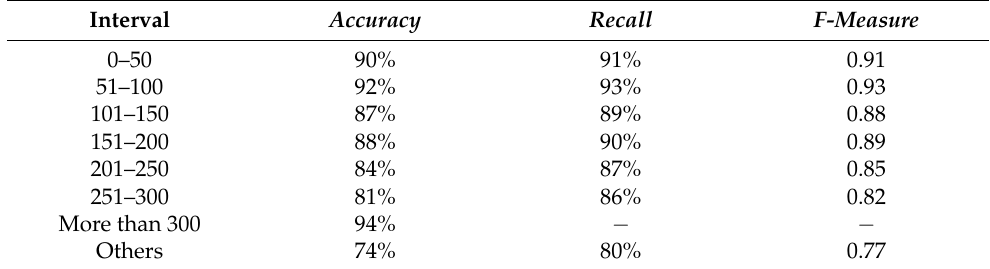
Table 2. Accuracy , recall and F-measure results discriminated into seven groups.